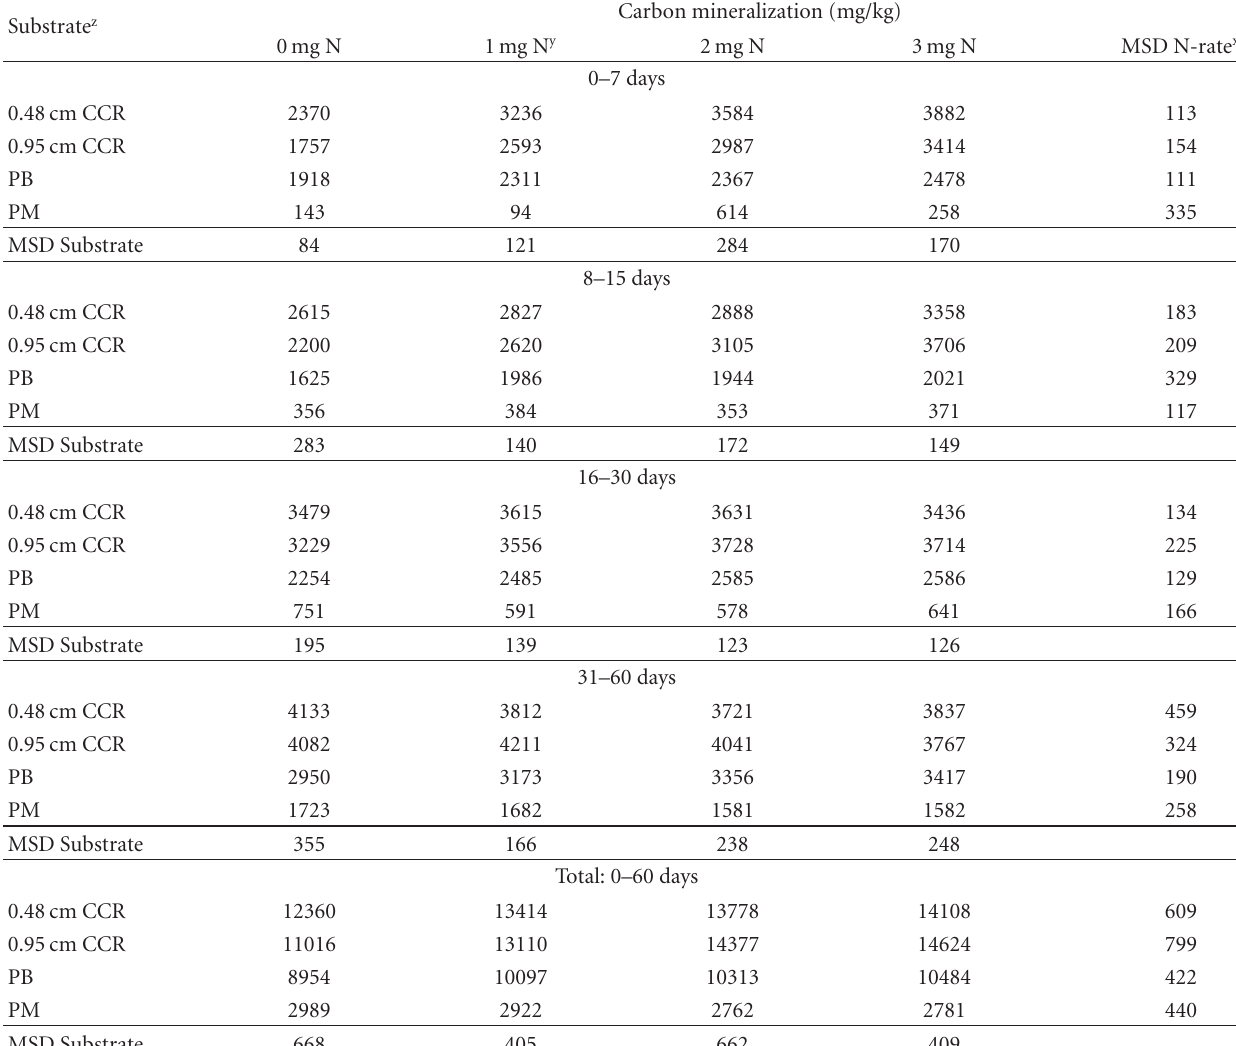
Table 4: Microbial respiration in clean chip residual, pine bark and peatmoss